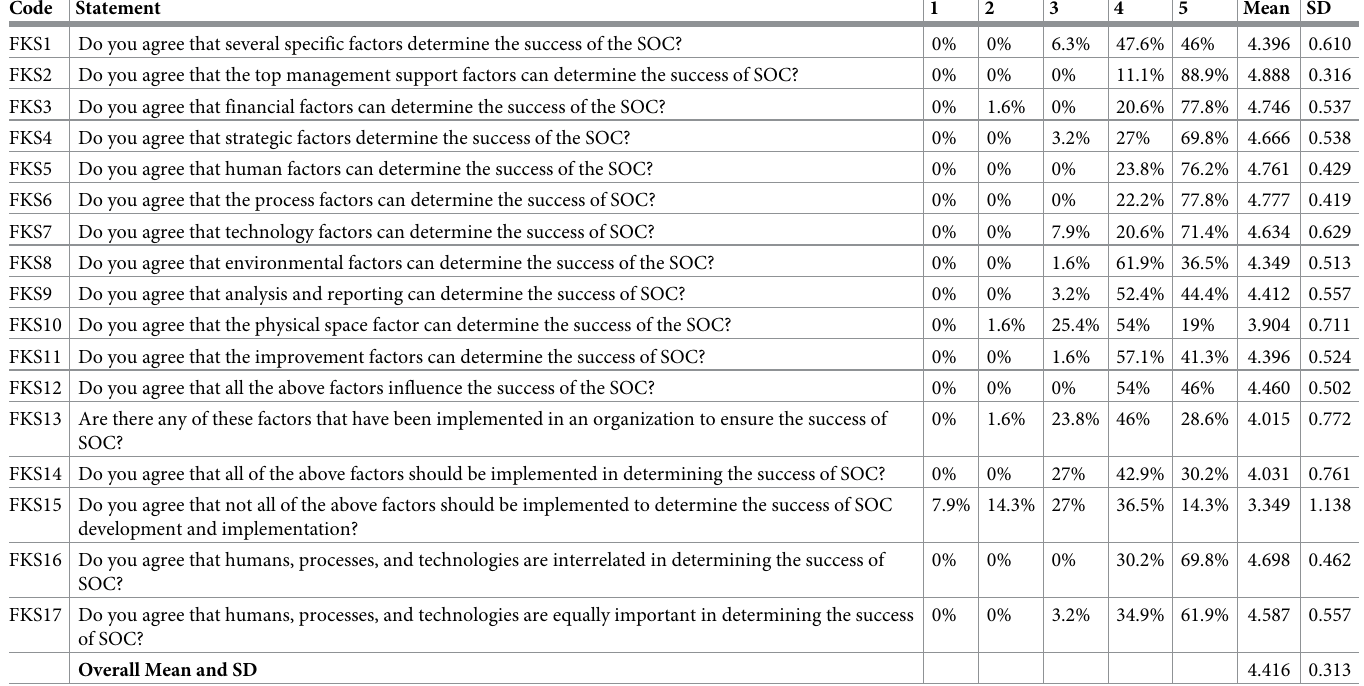
Table 11. Questionnaire on ten success factors of